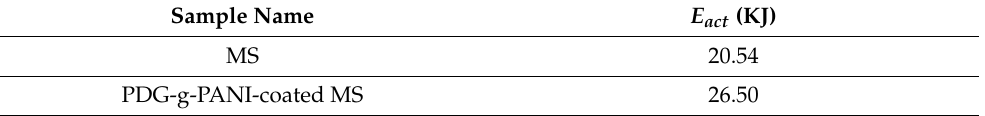
Table 4. Calculated activation energies of uncoated MS and PDG-g-PANI-coated MS.